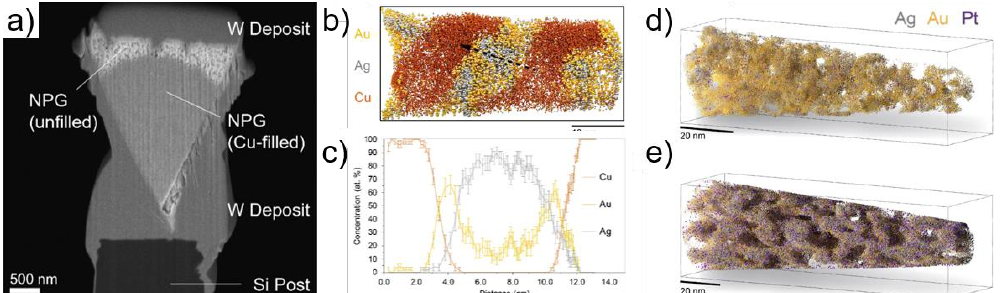
Figure 14. Exploring the effect of Pt on the structure of npAu. ( a ) SEM image after lift-out (and before FIB milling) of a partially filled npAu sample by Cu electrodeposition; ( b ) 3D atom map of a npAu specimen filled with Cu; and ( c ) 1D concentration profile along the black arrow in (b) highlighting the core-shell ligament structure with Au-rich shell and Ag-rich core. Trajectory overlaps between the Cu and the Au + Ag phases leads to a rather wide interface; 3D reconstruction of ( d ) dealloyed Ag 77 Au 22 Pt 1 and ( e ) dealloyed Ag 77 Au 20 Pt 3 specimen showing different ligament and pore size due to the different Pt content. Panel (a): reprinted from [ 175], Copyright (2017), with permission from Elsevier. Panels ( b – e ): reprinted from [176], Copyright (2018), with permission from Elsevier.